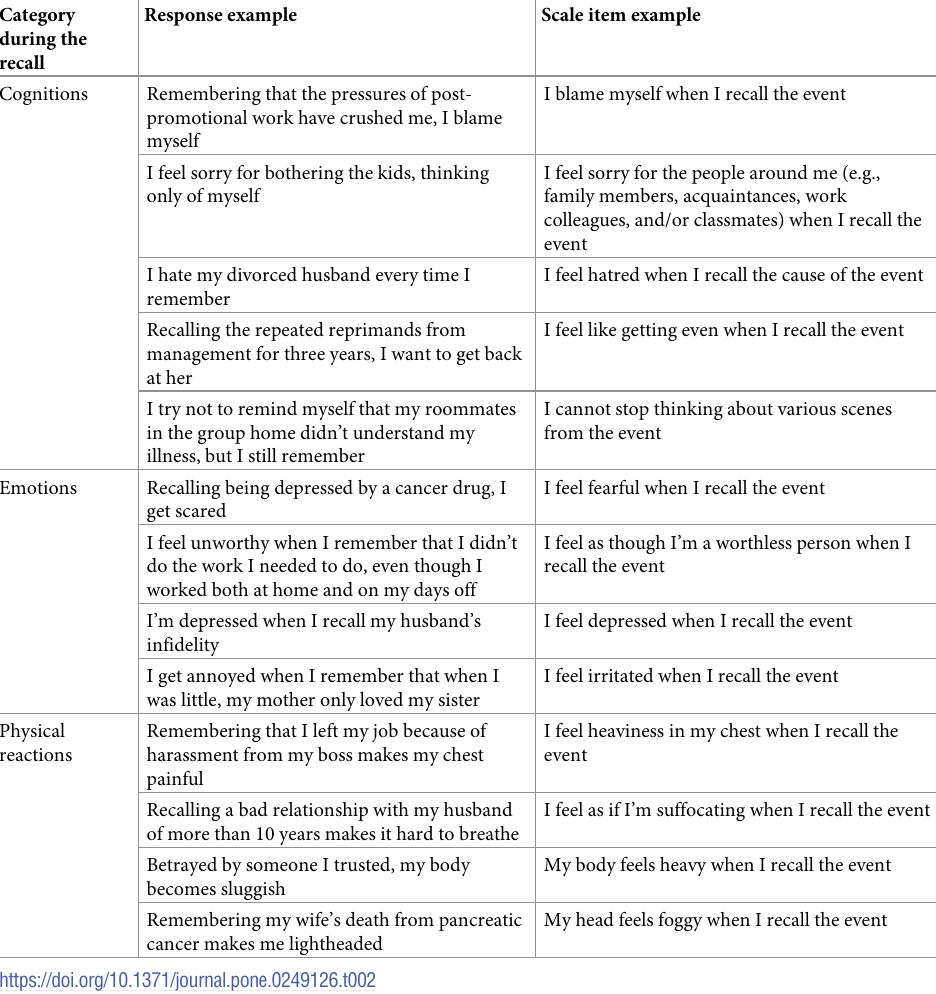
Table 2. Item development and content analysis based on semi-structured interviews with